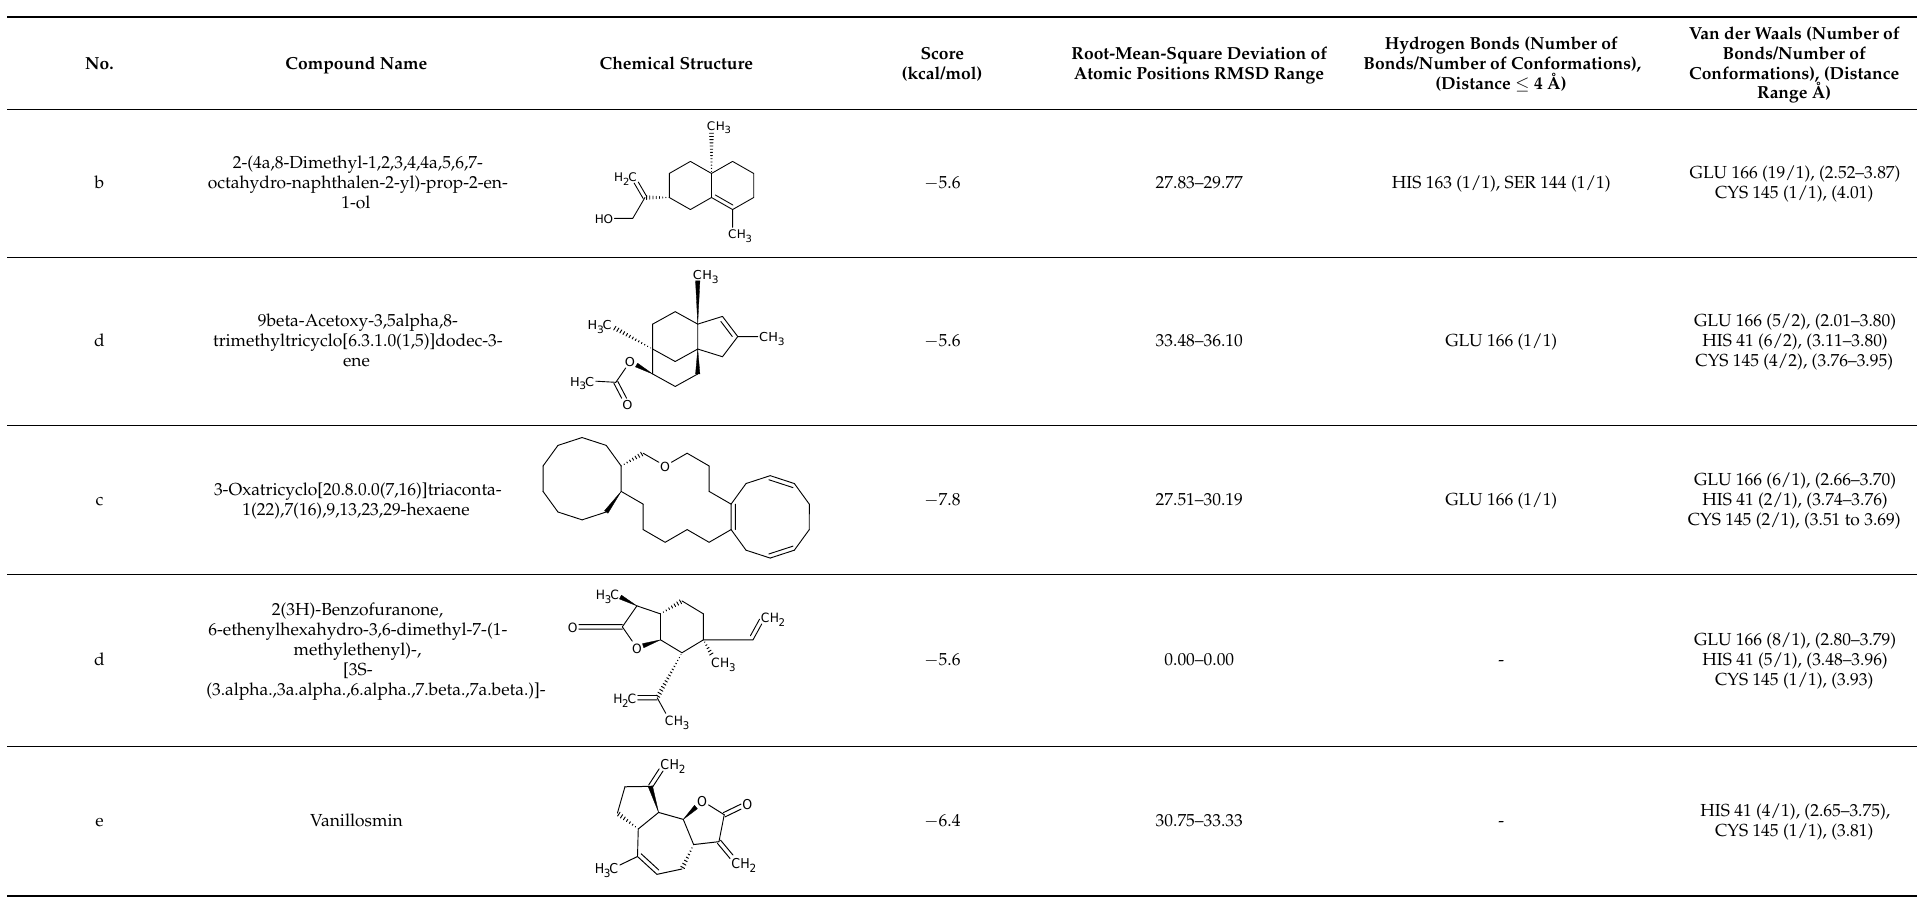
Table 1. The binding affinity of the active compounds docked with the active site of the main protease of SARS-CoV-2 with a particular focus on the GLU 166, HIS 41, and CYS 145 residues.